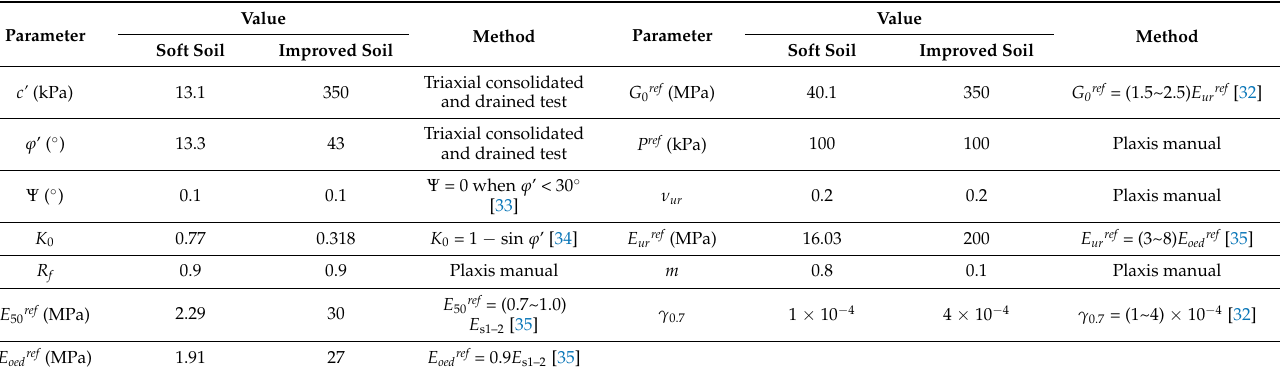
Table 1. Main parameters of the HSS